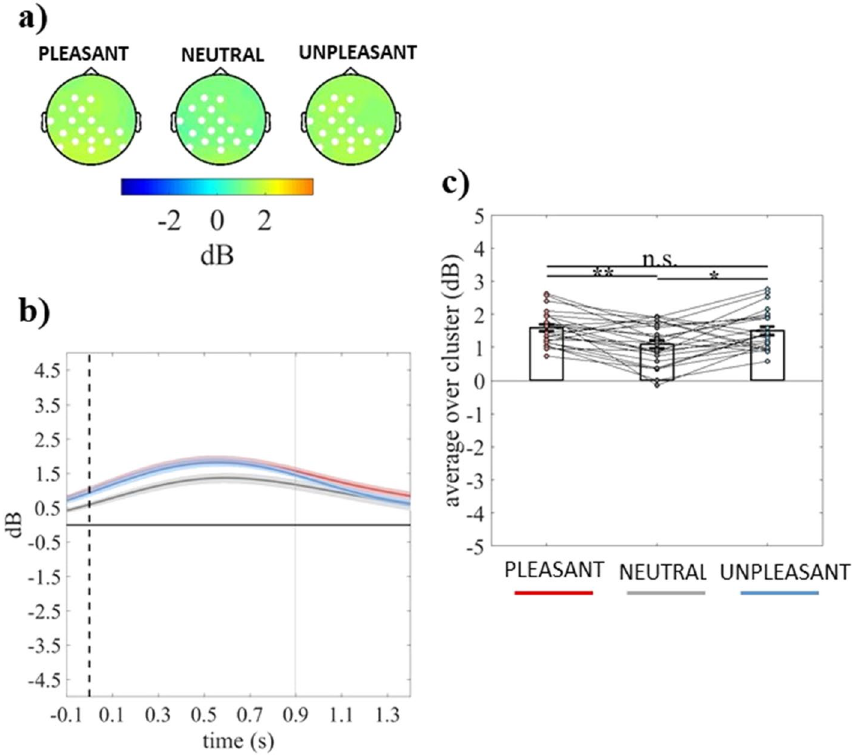
Figure 2. ( a ) Topography of the mean event-related delta power (dB) of individuals without dysphoria averaged over the significant time points (− 100 to 898 ms time window) for pleasant, neutral, and unpleasant conditions. ( b ) Time course of grand-average event-related delta power of individuals without dysphoria averaged over the significant electrodes for pleasant (red line), neutral (grey line), and unpleasant (light blue line) conditions. Shaded areas represent ± standard error of the mean (SEM) and the gray line represents the end of the significant time window (898 ms). ( c ) Mean event-related delta power of each participant (in the group without dysphoria) averaged over the significant electrodes and time points for pleasant, neutral, and unpleasant conditions. Each circle represents one participant; colored frames represent the mean event-related delta power across all participants and the solid black lines represent ± SEM. * p < .05; ** p <